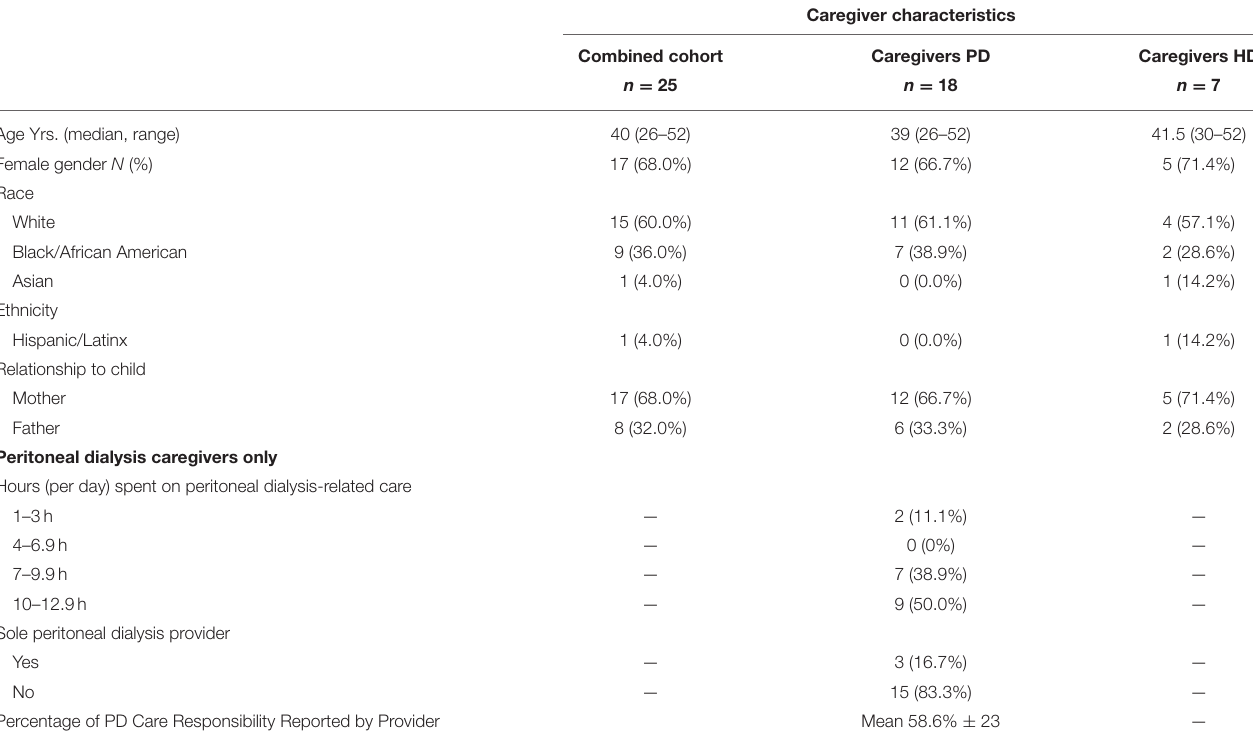
TABLE 1 | Pediatric dialysis caregiver and patient